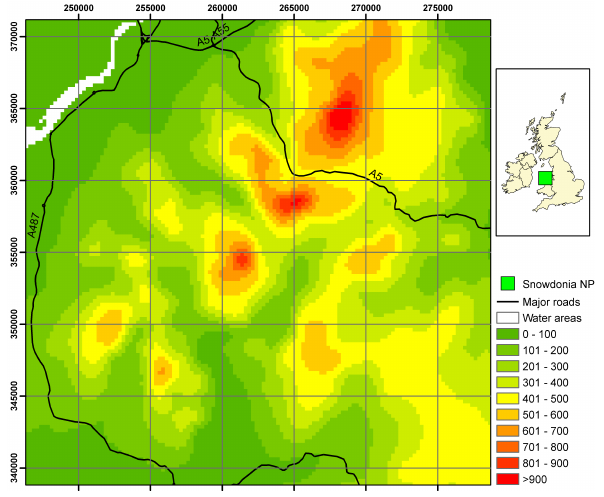
Fig. 1b. Annual precipitation (mm) gridded at a 1km resolution for